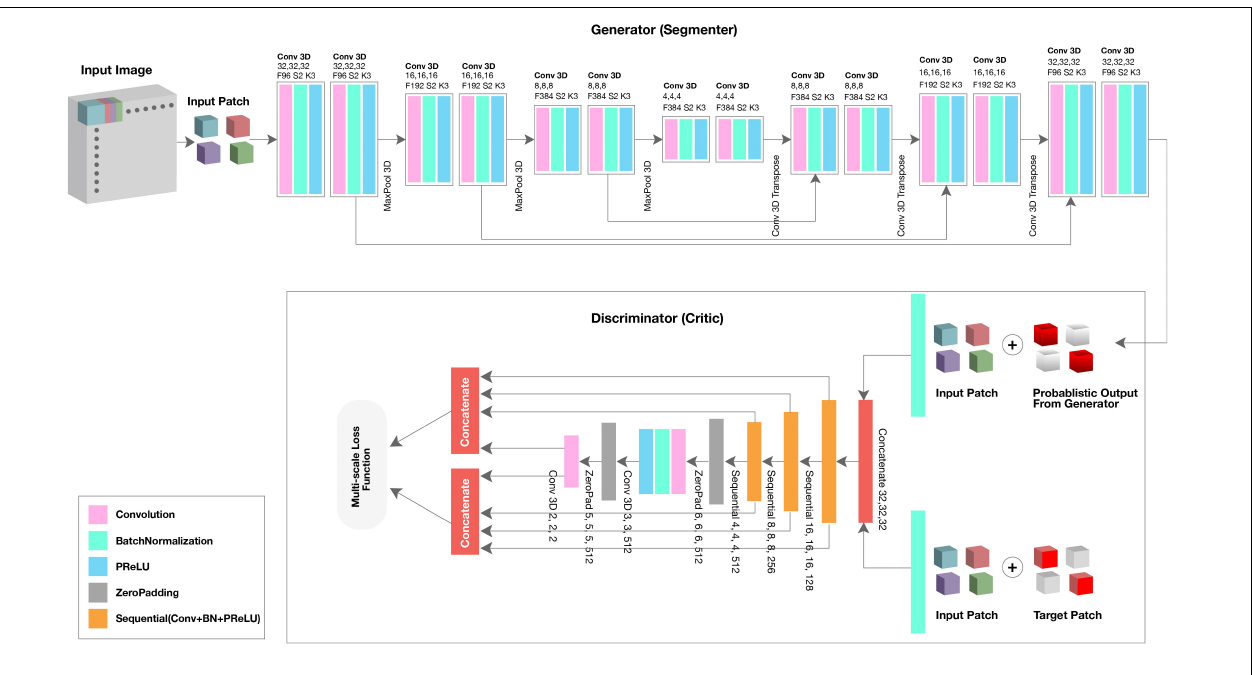
FIGURE 1 | Architecture of proposed FetalGAN network. TABLE 1 | Comparison of FetalGAN, 3D U-Net, and